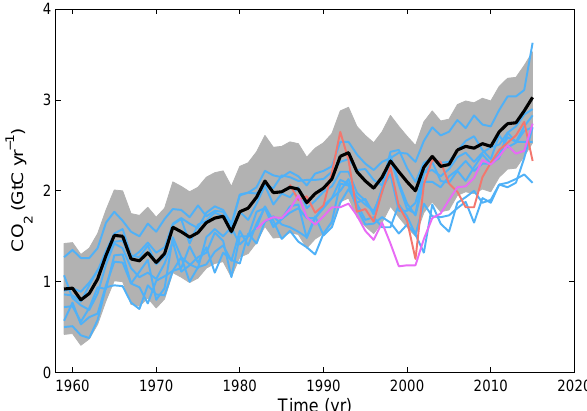
Figure 7. Comparison of the anthropogenic atmosphere–ocean CO 2 flux showing the budget values of S OCEAN (black; with ± 1 σ uncertainty in grey shading), individual ocean models before nor- malisation (blue), and the two ocean data-based products (Röden- beck et al. (2014) in salmon and Landschützer et al. (2015) in purple; see Table 6). Both data-based products were adjusted for the pre-industrial ocean source of CO 2 from river input to the ocean, which is not present in the models, by adding a sink of 0.45GtCyr − 1 (Jacobson et al., 2007), to make them comparable to S OCEAN . This adjustment does not take into account the anthro- pogenic contribution to river fluxes (see Sect.